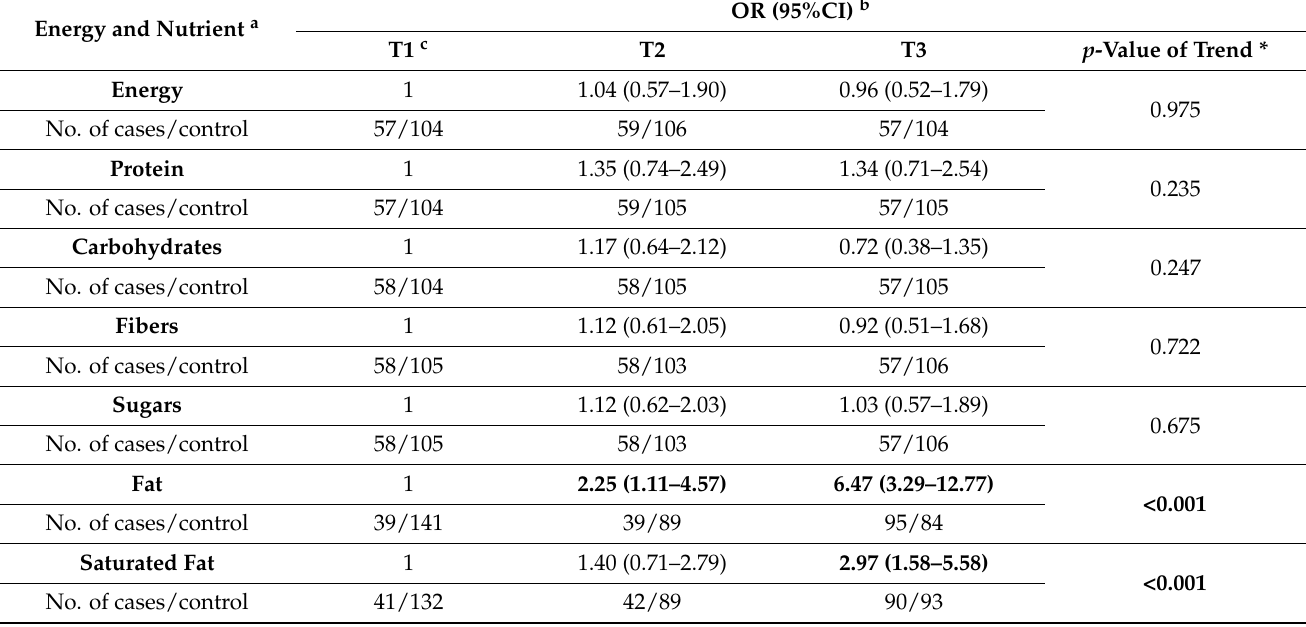
Table 3. Odds ratios (ORs) and corresponding 95% confidence intervals (CIs) according to the